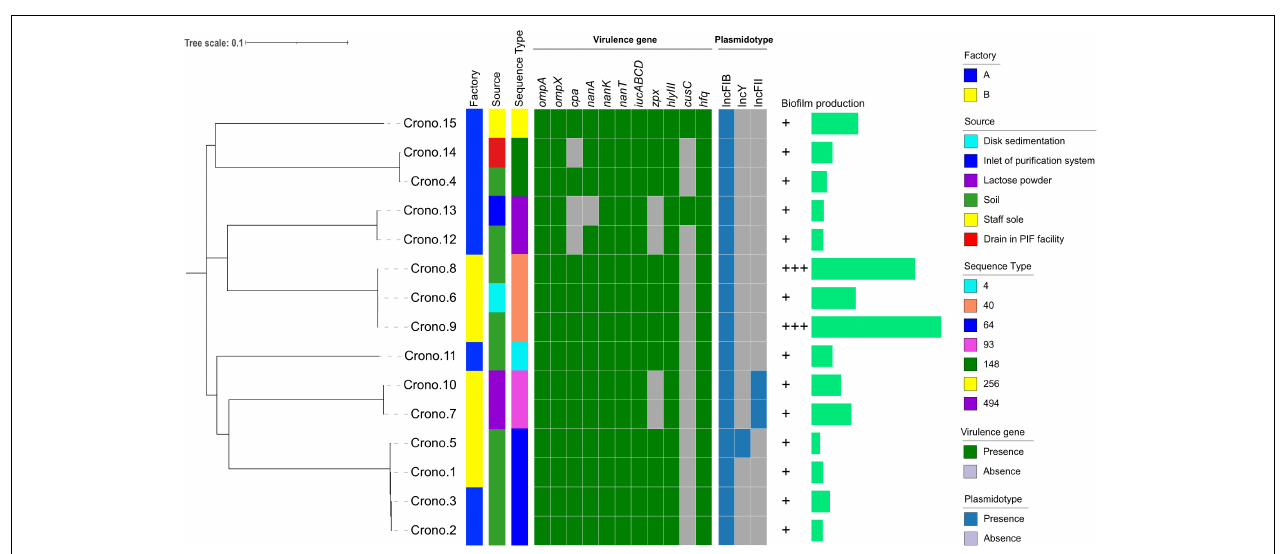
FIGURE 1 | Phylogenetic tree and heat-map summary of presence of virulence genes and plasmids possessed by the 15 C. sakazakii isolates. The phylogenetic tree shown on the left was generated using CFSAN_SNP pipeline and FastTree v2.1 taking the core genome (3,440 core genes were analyzed) SNPs as input and was visualized with iTOL. Isolation information including PIF manufacturing facility location and sources as well as the sequence types are shown with stripes in different colors. The presence and absence of virulence genes and plasmidotype are shown with heat map. The biofilm production of all 15 isolates are shown with symbols (+ ∼ + +) and simple bar chart exhibiting their capacity of biofilm